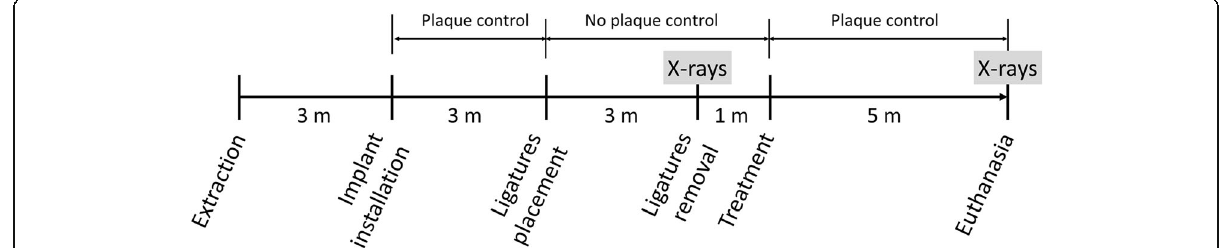
Fig. 1 Timeline of the experiment. m =